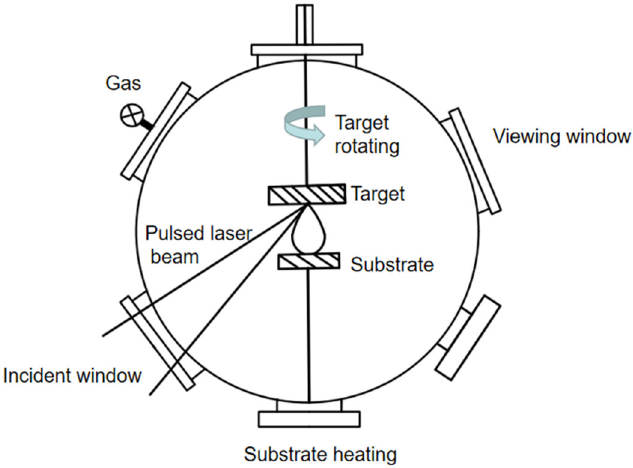
Figure 2. Schematic diagram of pulsed laser deposition.